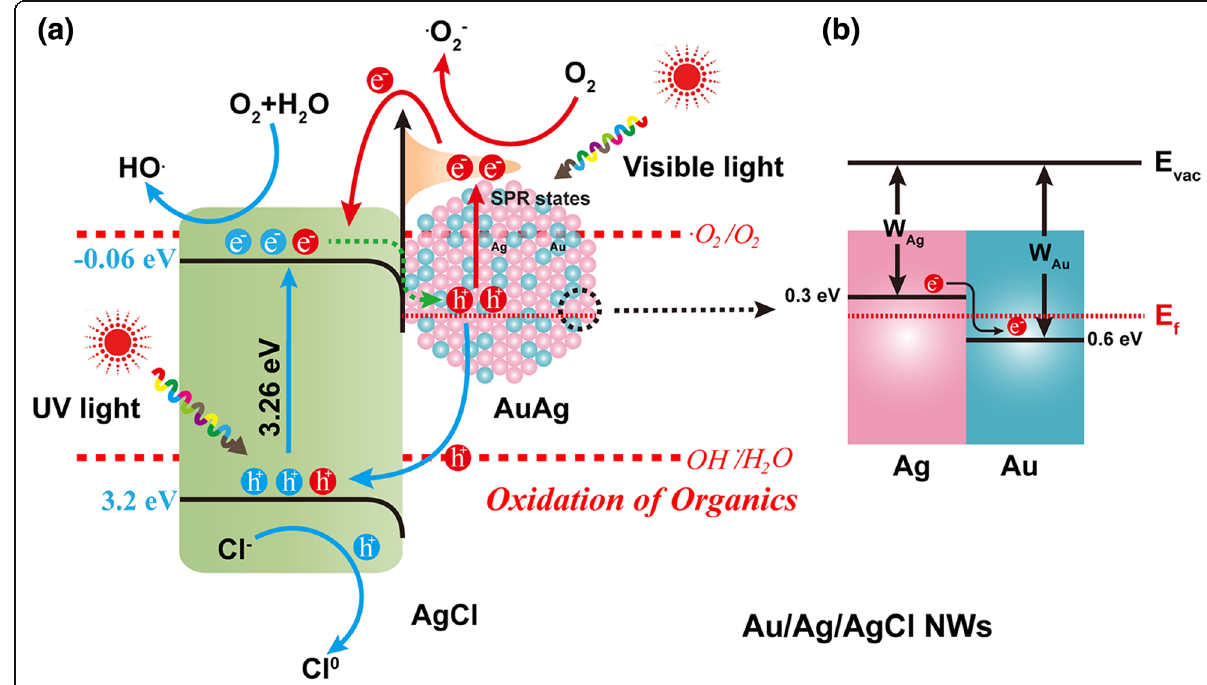
Fig. 10 The proposed photocatalytic mechanism of Ag/Au/AgCl hollow NWs. a Schematic diagram of charge transfer. b Electron transfer in